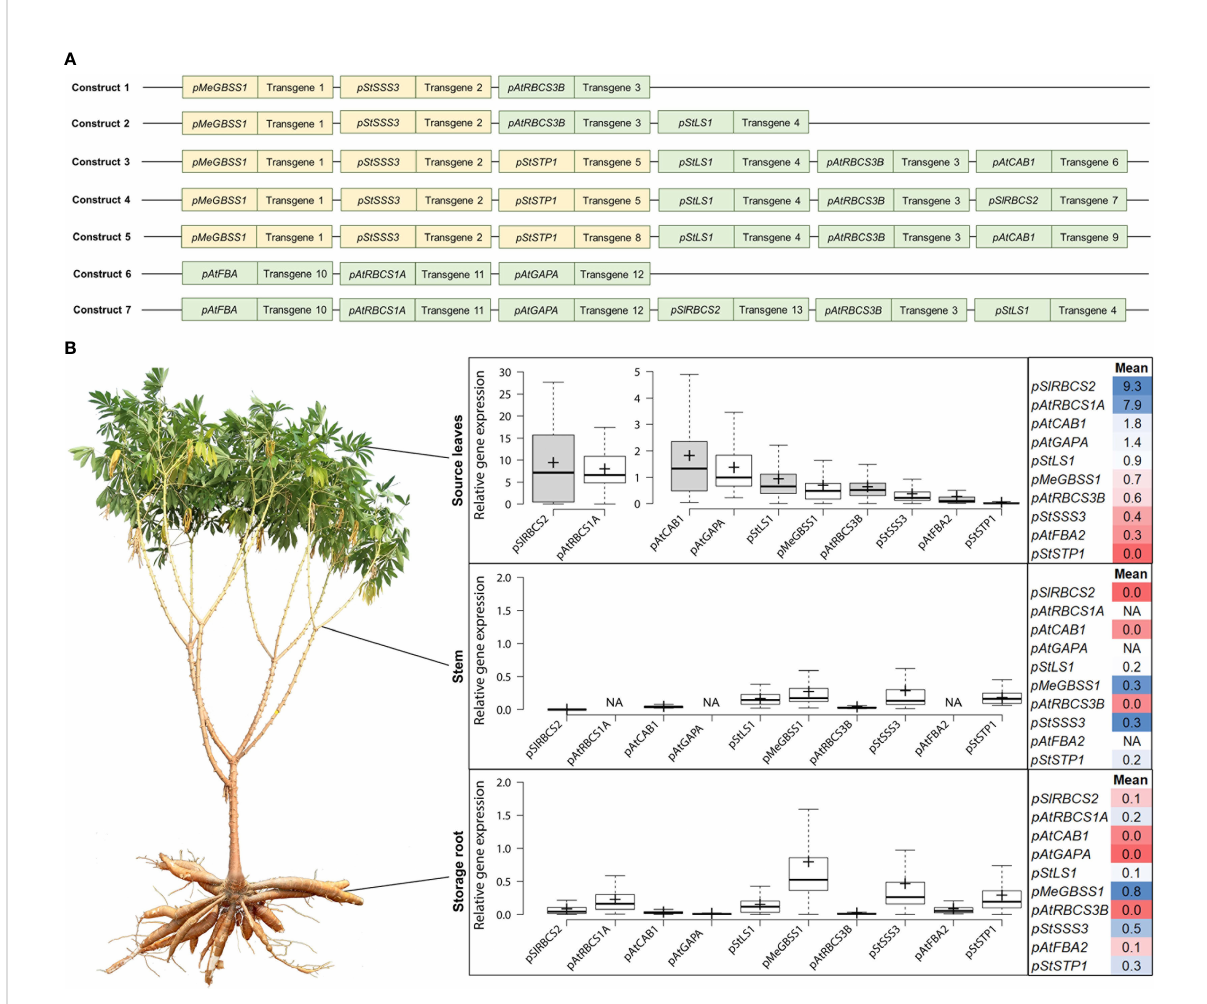
FIGURE 1 Summary of the approximate promoter activity of ten different promoters in source leaves, stem, and storage root. (A) Composition of the seven multigene constructs analyzed for gene expression of the individual target genes (target genes not shown). Orange indicates promoter choice for desired expression in heterotrophic tissues, green indicates promoter choice for desired expression in autotrophic tissues. (B) The relative gene expression (normalized to MeGAPDH ) of different transcripts was determined and the data was used to infer the approximate activity of the promoter element controlling its expression. Field-grown cassava plants were used to sample fully exposed source leaves (in the afternoon), stem pieces at the lower end of the fi rst branching point, and storage root material from the two thickest storage roots per